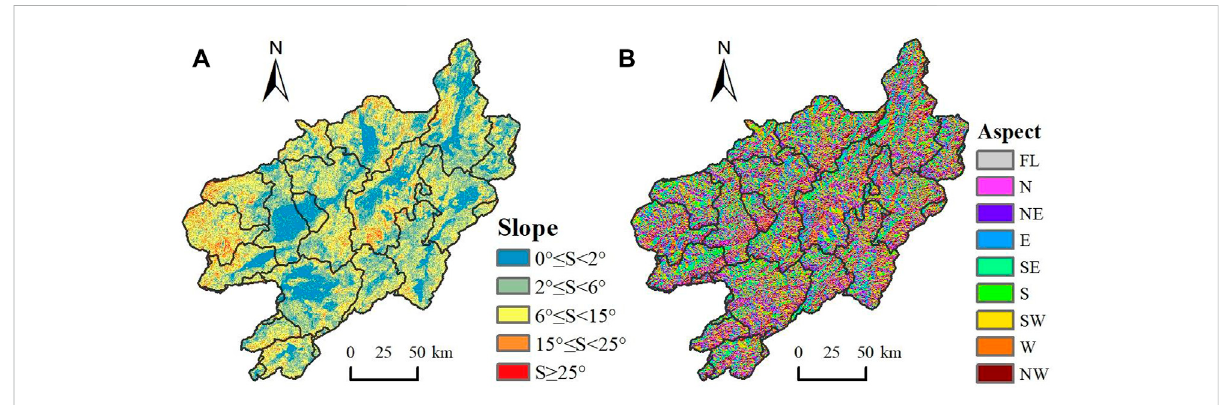
FIGURE 2 SpatialdistributioncharacteristicsofslopeandaspectintheupperreachesofGanjiangRiverBasin.FL,N,NE,E,SE,S,SW,W,andNWdenote fl at